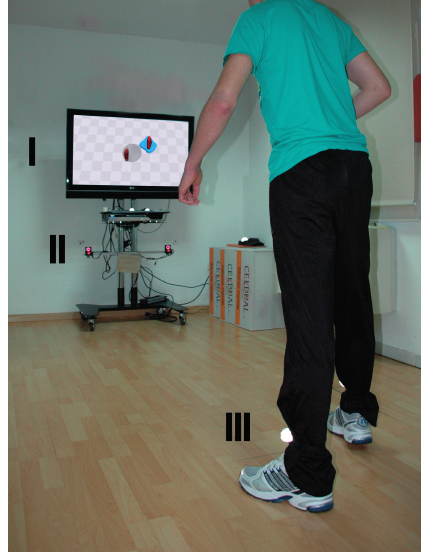
Figure 2. Participant interacting with the virtual rehabilitation system. The participant’s movements are tracked by two infrared cameras (II), which estimate the position of reflective markers attached to their ankles (III). The position of the markers are then transferred to the virtual environment, shown in a TV screen (I).